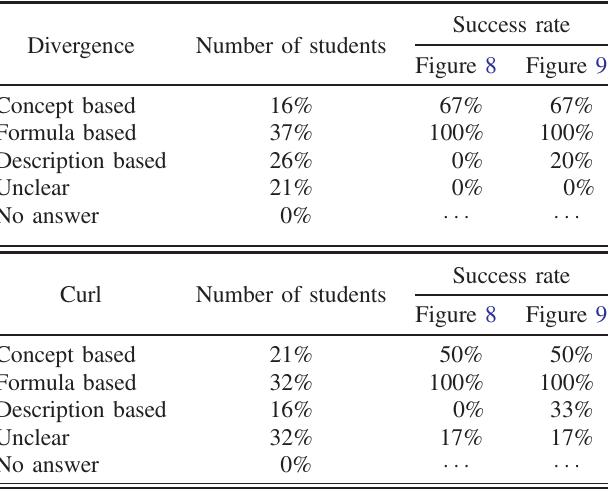
TABLE IV. The prevalence and success rate of strategies students used to determine the divergence and curl of vector fields based on graphical representations used in the post-test ð N ¼ 19 Þ .